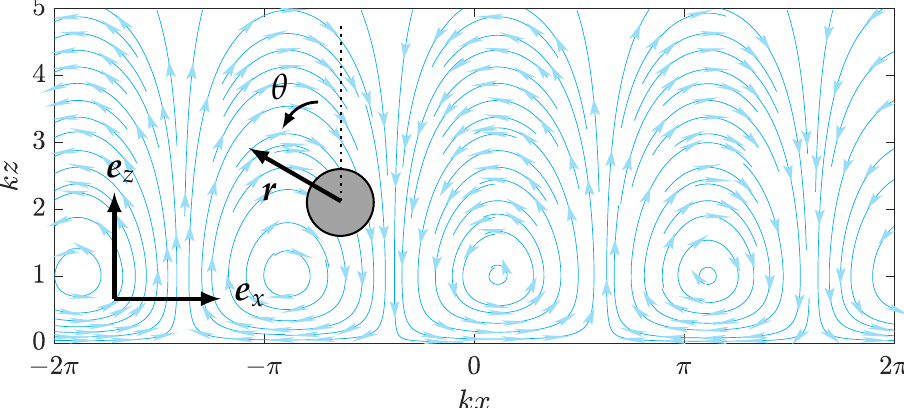
Figure 1. Spherical swimmer in wall-induced oscillatory flow. The swimmer moves in the xz -plane and has propulsive velocity v in the direction indicated by r , which makes an angle θ to the z axis of the laboratory